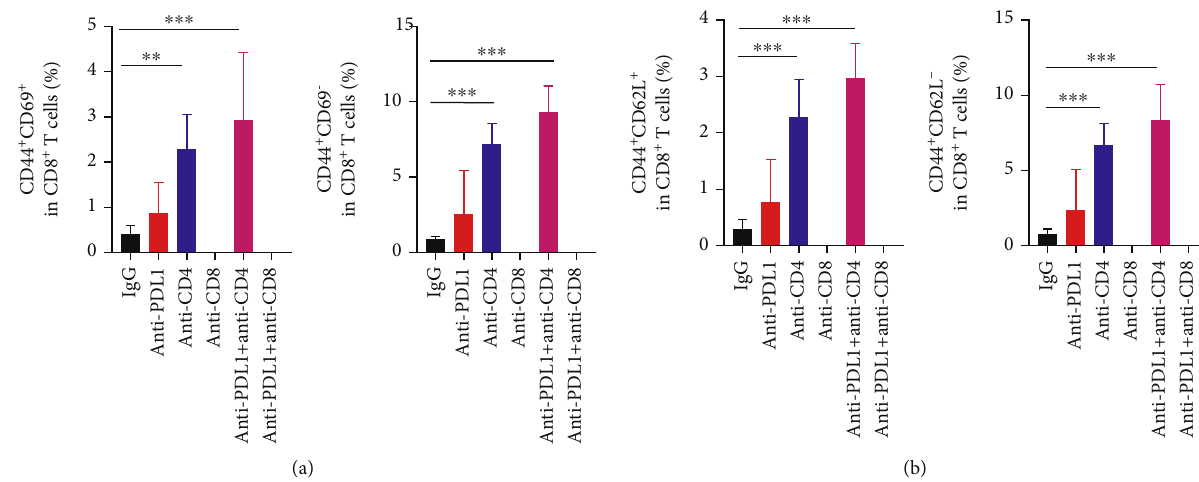
Figure 3: PD-L1 blockade and CD4 + T cell depletion additively promoted CD8 + T cell activation in tumor-draining lymph nodes. CT26 tumor-bearing mice were prepared and treated as described in Figure 1. On day 12 post anti-PD-L1 treatments, tumor-draining lymph nodes were harvested and analyzed by fl ow cytometry. (a) The percentages of CD44 + CD69 + and CD44 + CD69 - cells in the CD8 + T cell population. (b) The proportions of CD44 + CD62L + and CD44 + CD62L - cells in CD8 + T cell population. Signi fi cant di ff erences were determined by one-way ANOVA. Data were from one experiment representative of two independent experiments with similar results ( n = 7 − 8 mice per group). Data were shown as means ± SD . ∗∗ P < 0 : 01 , ∗∗∗ P < 0 : 001